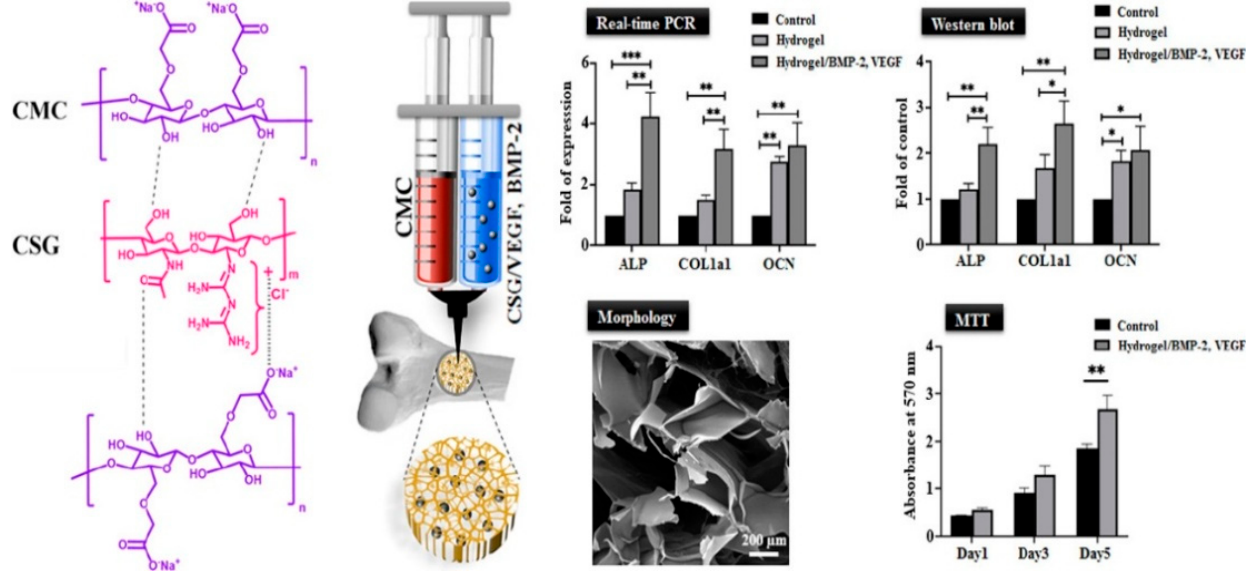
Figure 19. Synthesis of cationic biguanidinyl chitosan and anionic carboxymethylcellulose and its use in encapsulation of endothelial growth factor (VEGF) and recombinant bone morphogenetic protein 2 (rBMP-2) (*,** and *** denotes to significant error) (adapted with permission from Divband et al., 2021).